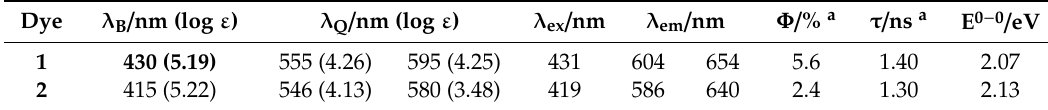
Table 1. Absorption and emission data in toluene